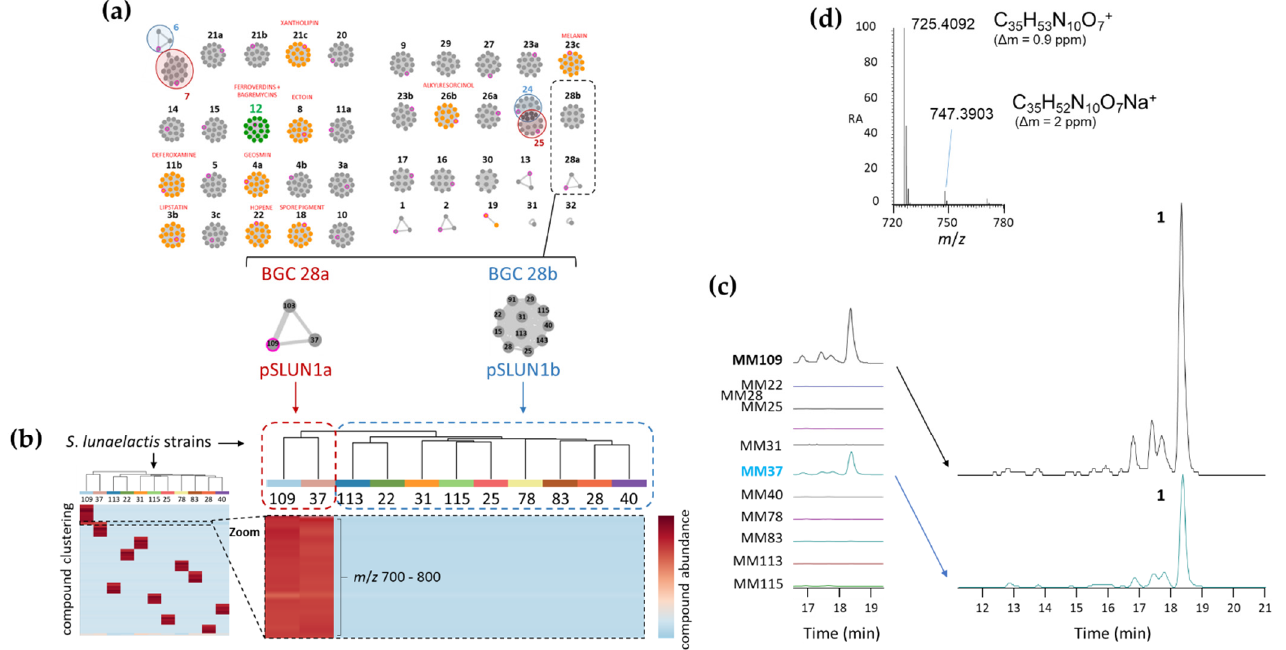
Figure 2. ( a ) Genome mining of S . lunaelactis strains where the 42 predicted BGCs are grouped in ‘grapes’ of nodes where each node represents a BGC in one strain (from [22]). Note the two grapes corresponding to BGC 28a and to BGC 28b found in strains either containing the linear plasmid pSLUN1a or pSLUN1b, respectively. ( b ) Heatmap of the metabolomic analysis of 11 S . lunaelactis strains grown on ISP7 media. The zoom on the heatmap highlights the differential production patterns for metabolites with m / z comprised between 700 and 800 Da and only present in the extract of S . lunaelactis strains that possess BGC 28a (MM109 T and MM37). ( c ) Extracted ion chromatograms (EIC, from m / z 700 to 800) of the full extract of the 11 strains with a focus on the retention times of signals associated with compounds only detected in S . lunaelactis strains with BGC 28a (MM109 T and MM37). ( d ) HRMS-predicted molecular formula of compound 1 (for both the proton and the sodium adducts) associated with the main signal detected in EICs of S . lunaelactis strains MM37 and MM109 T .